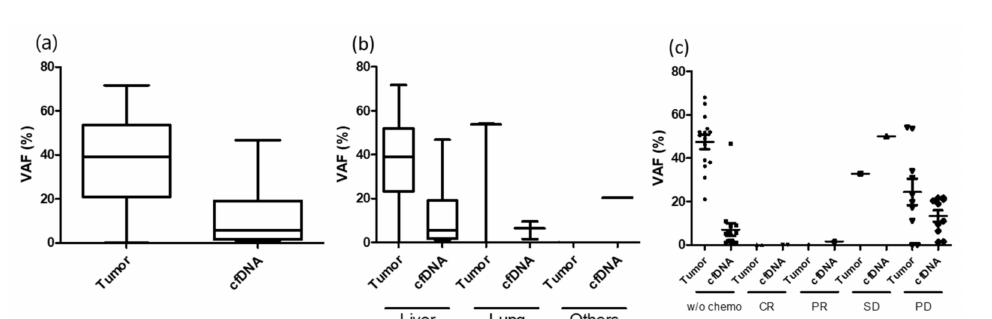
Figure 2. VAF difference between tumor and plasma under various conditions. ( a ) Mean VAF difference between tumor and plasma; ( b ) VAF difference between tumor and plasma under metastatic organ; ( c ) VAF difference between tumor and plasma under neoaduvant chemotherapy